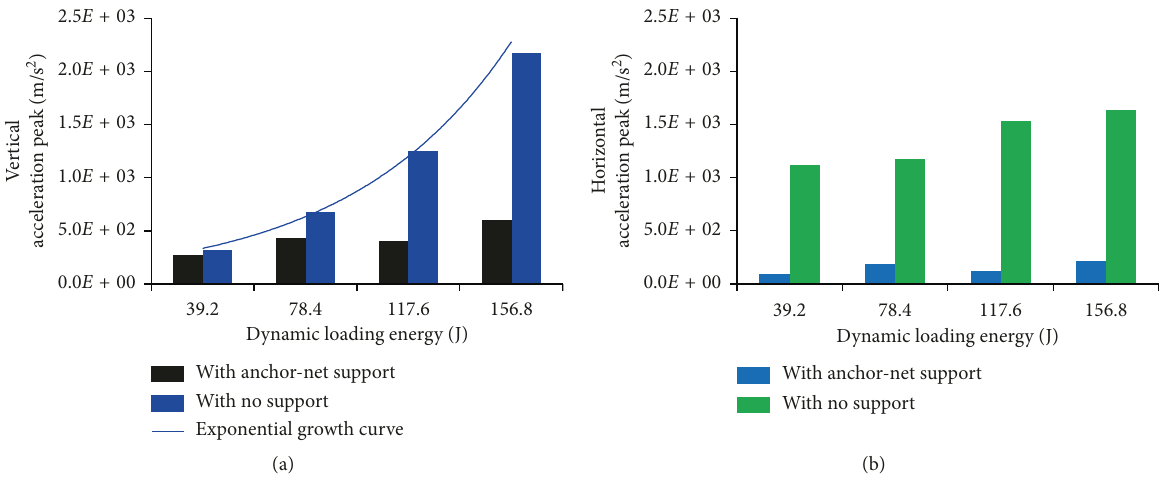
Figure 7: Variations of acceleration peaks in vertical (a) and horizontal (b) directions at different dynamic loading stages.